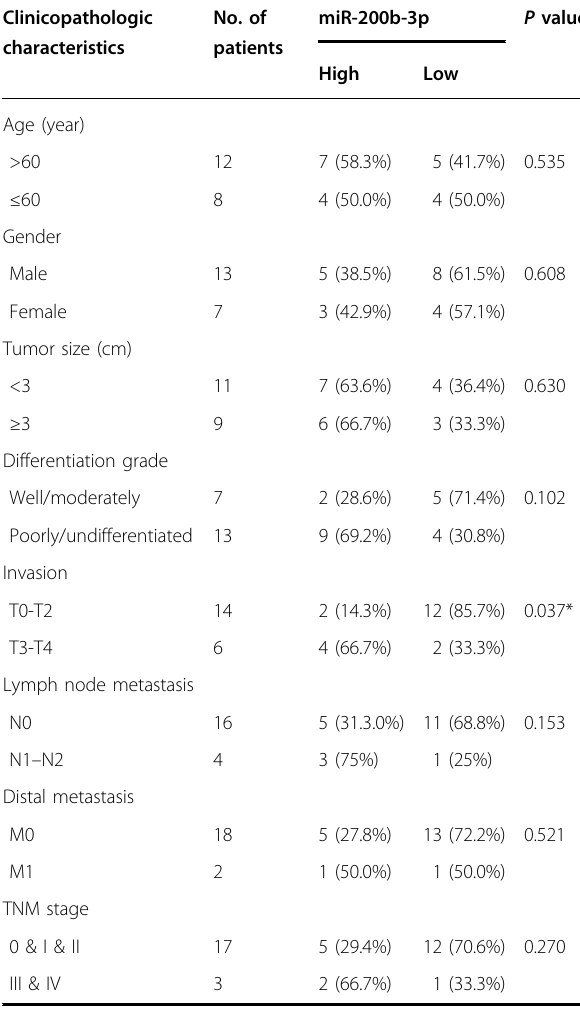
Table 3 The correlation analysis between miR-200b-3p expression and clinicopathologic characteristics in lung